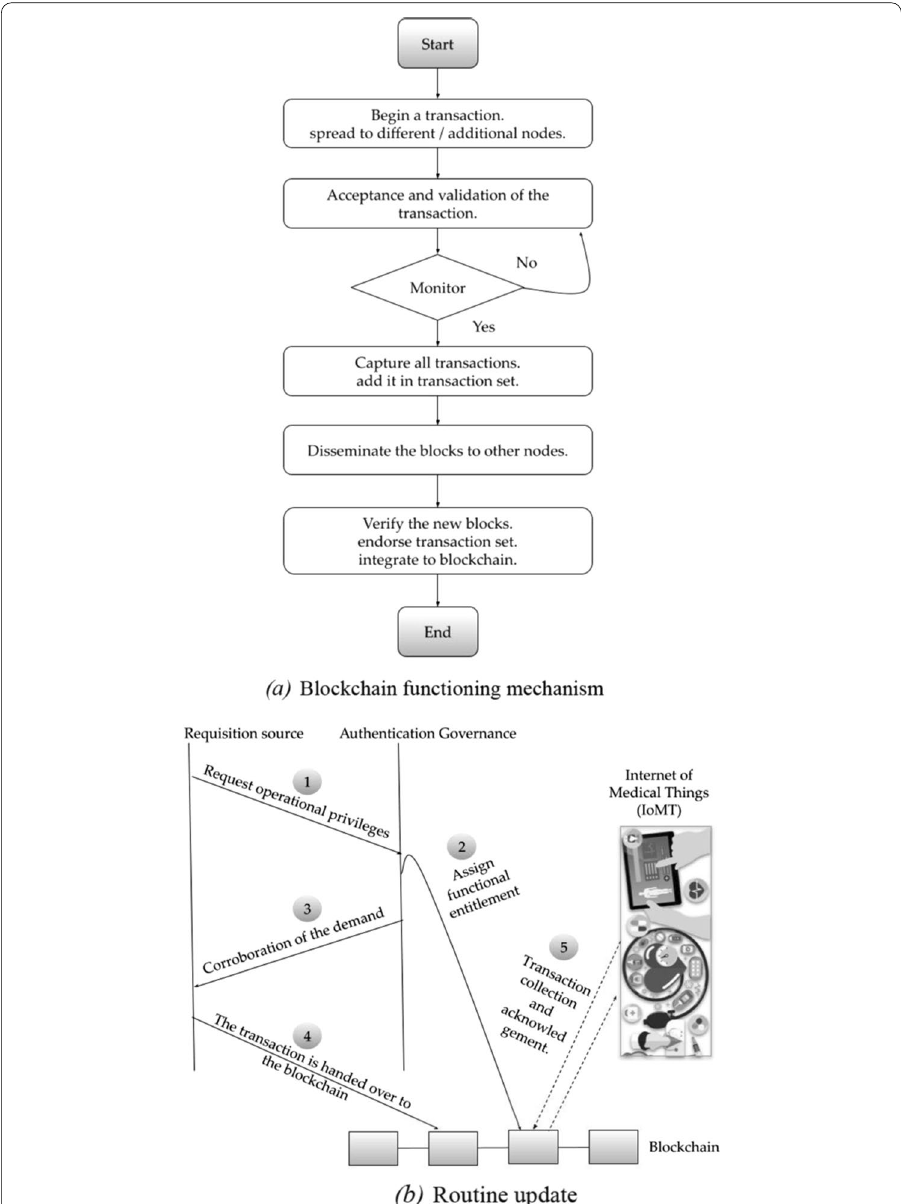
Fig. 1 Individual block’s Payload and Hashing outcome. Each block holds a payload, (2) hash of block and c hash of preceding block. In proposed scheme, SHA-384 was used for hashing of constant block size of 1088 bits each. Within selected Blockchain setup, cryptographic hash (SHA-384 (as mentioned in this figure)) methodology enables: a address derivation, b generation of unique identifiers, and c block payload and header’s integrity. Blocks were connected together through each block, comprising the SHA-384 (hash) digest of the preceding block’s header, thus creating the Blockchain. If a formerly distributed block was altered, it would yield dissimilar hash. By linking the original state and the capability to authenticate each block, handlers can autonomously approve the present state of the